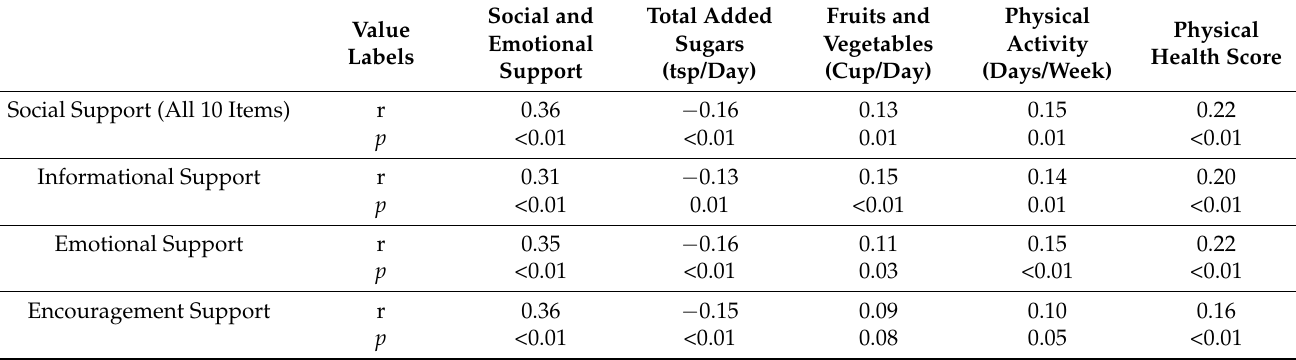
Table 4. Convergent and predictive validity of Social Support to Eat Better and Move